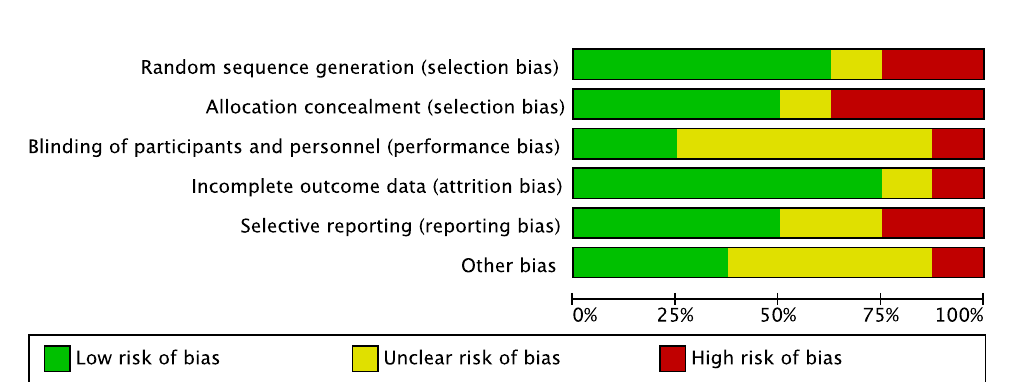
Fig. 2 Methodological quality